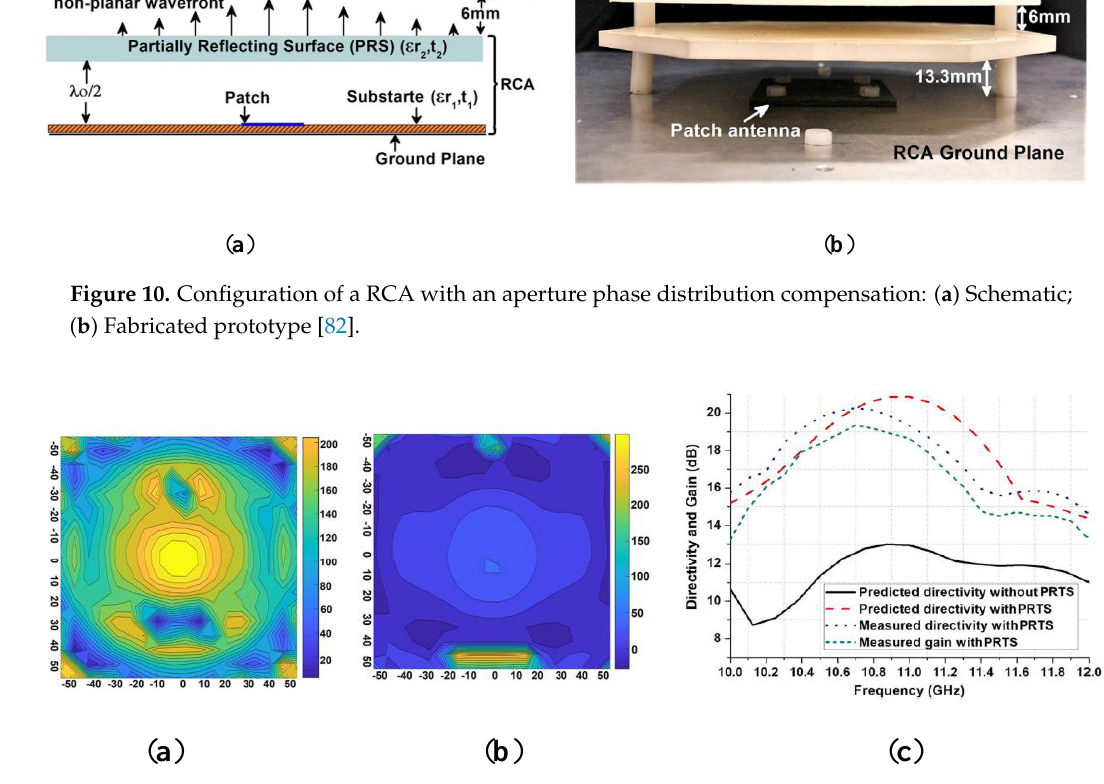
Figure 11. Results of the RCA with the aperture phase correction: ( a ) Aperture phase distribution after correction; ( b ) Aperture phase distribution before correction; ( c ) Antenna directivity